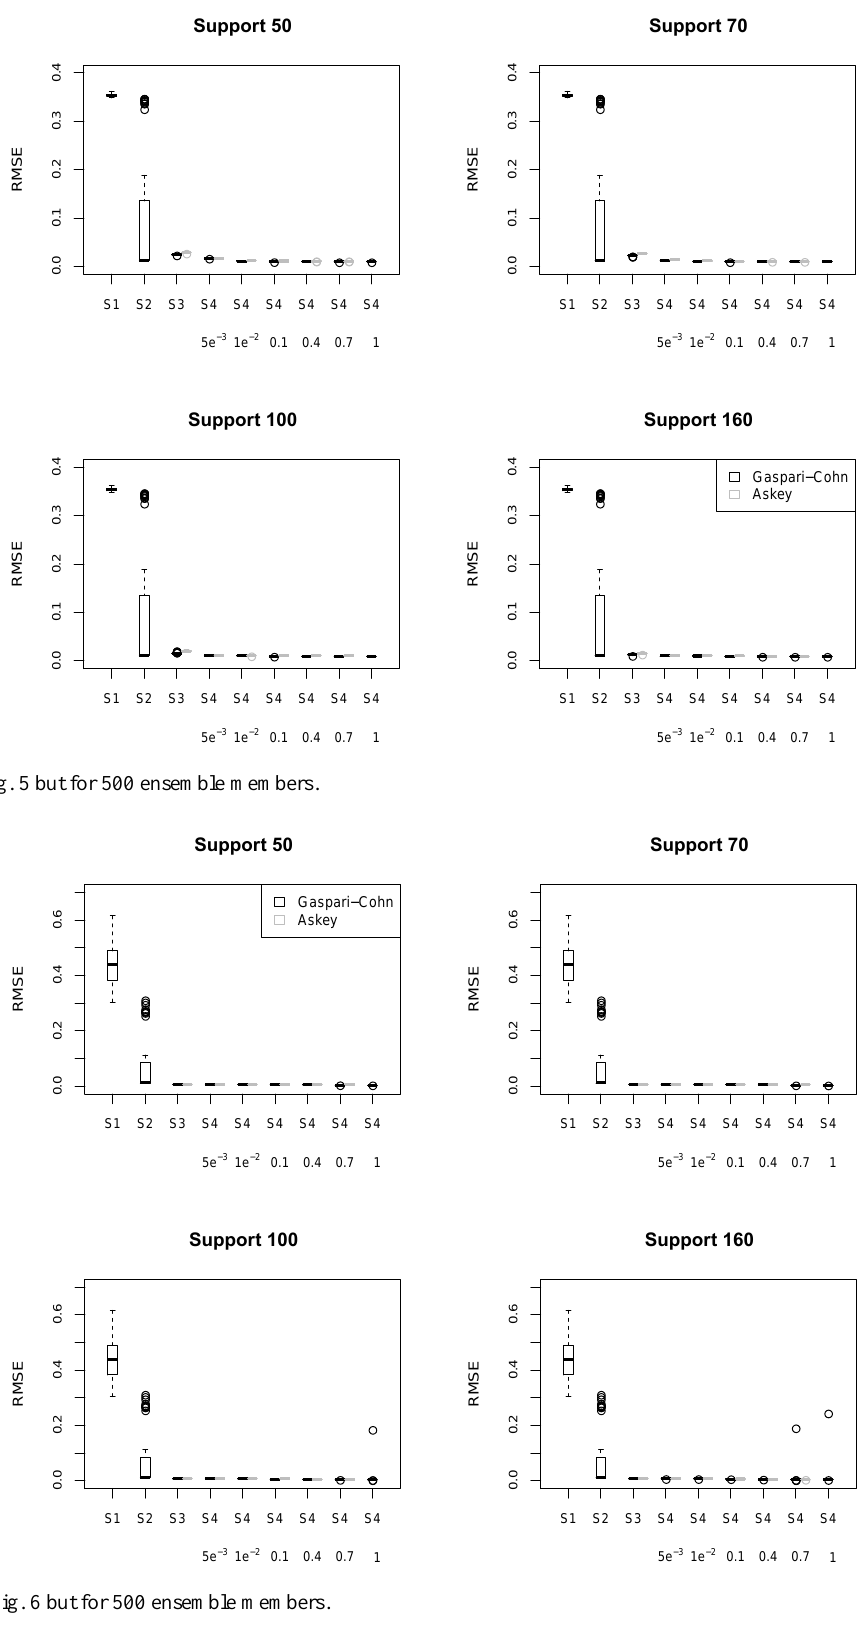
Figure 10. Same as Fig. 6 but for 500 ensemble